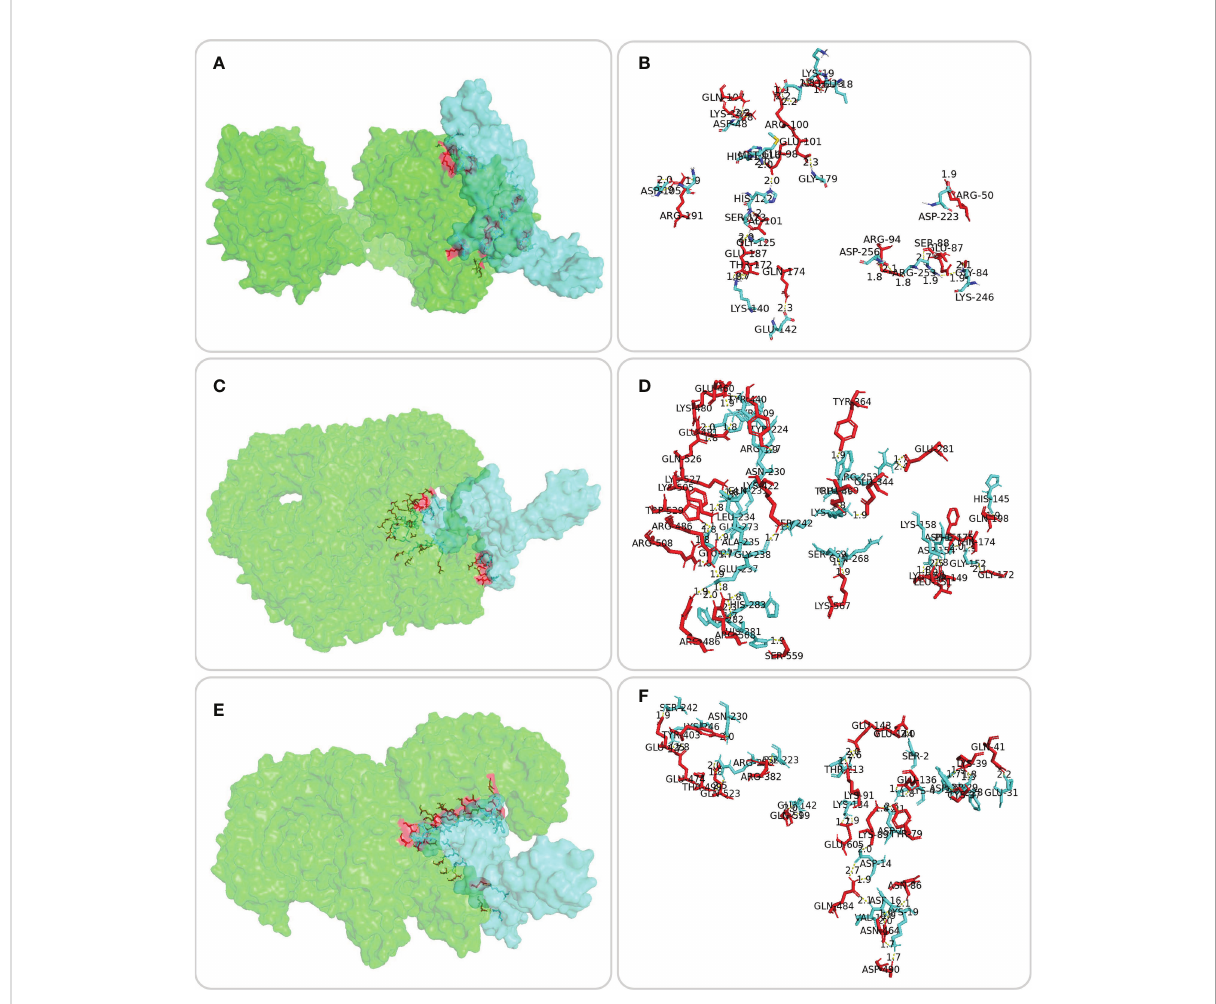
FIGURE 3 Molecular docking between the MP3RT vaccine and the HLA-DRB1*01:01 molecule, TLR-2, and TLR-4 receptors. Molecular docking of the MP3RT vaccine (blue) with HLA-DRB1*01:01 ( A , green), TLR2 ( C , green), and TLR4 ( E , green) was performed using ClusPro2.0 server (https:// cluspro.bu.edu/home.php). PDB fi les for TLR2 (6NIG) and TLR4 (4G8A) receptors were obtained from the Molecular Modeling Database (MMDB, https://www.ncbi.nlm.nih.gov/structure/). PyMOL2.5.3 was used to visualize and analyze the amino acid sites where the MP3RT vaccine (blue) docked with HLA molecule ( B , red), TLR2 ( D , red), and TLR4 ( F , red). The detailed information of ligand amino acid, distance, and acceptor amino acid for molecular docking of the MP3RT vaccine with HLA-DRB1*01:01, TLR-2, and TLR-4 can be found in Table S1, Table S2, and Table S3,